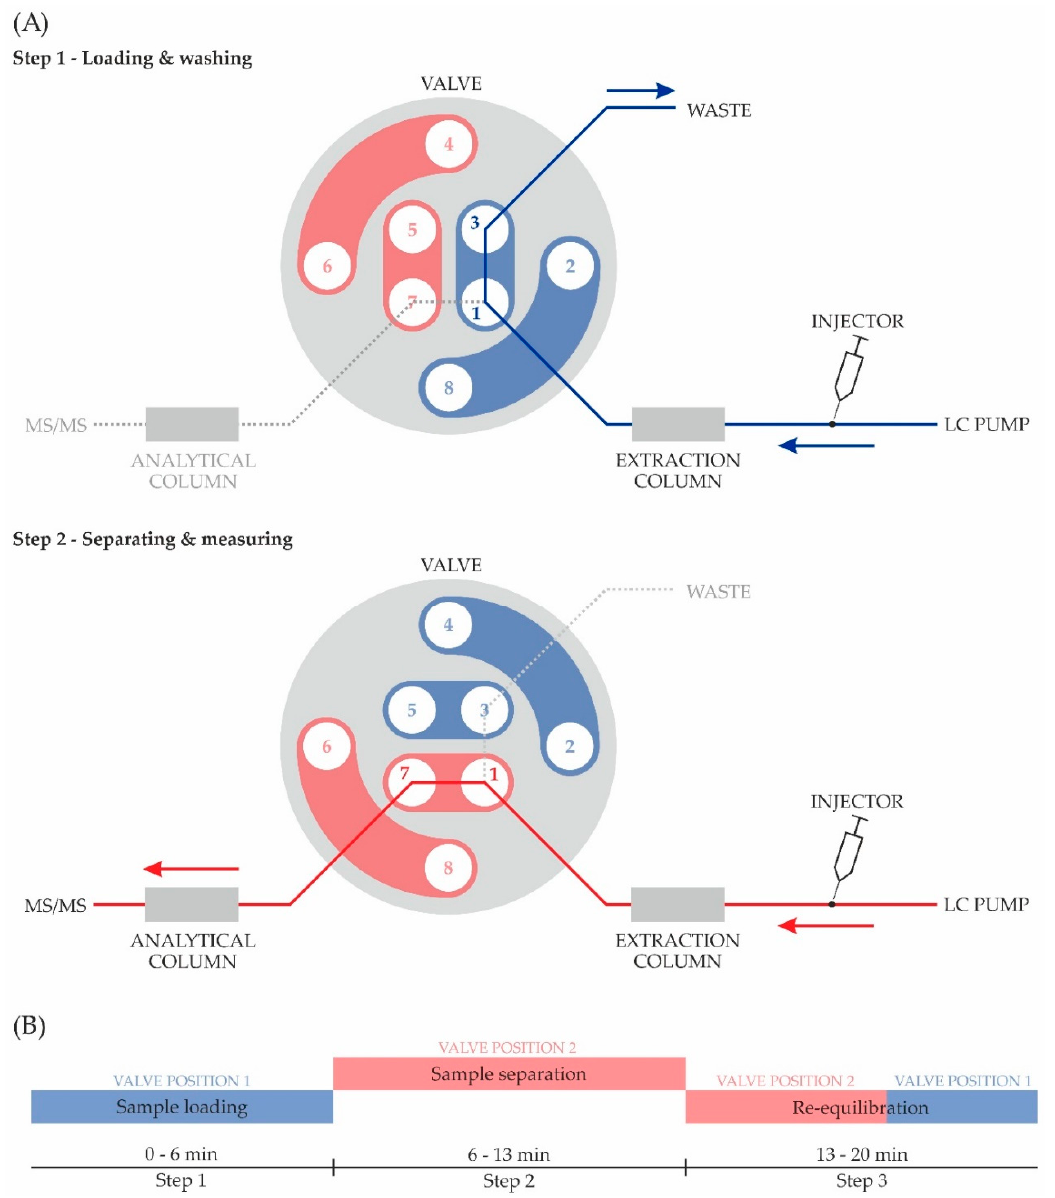
Figure 2. Online solid-phase extraction procedure: ( A ) Schematic illustration of the valve switch system: Step 1, Analyte loading on extraction column and washing of interfering substances from urine to improve detection in the following instrumental analysis; Step 2, Elimination of the analyte from extraction column, separation on analytical column and tandem mass spectrometry (MS/MS) measurement; ( B ) Temporal progression of the experimental procedure.